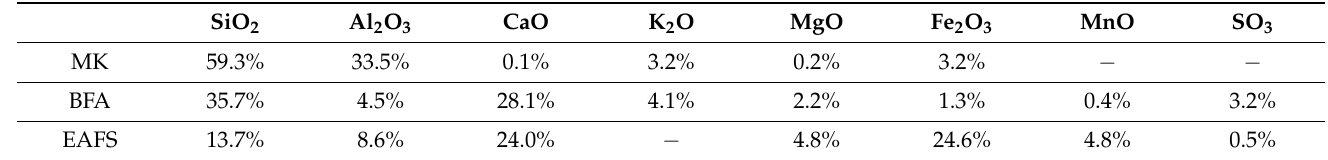
Table 2. Main oxide composition of GPC precursors.